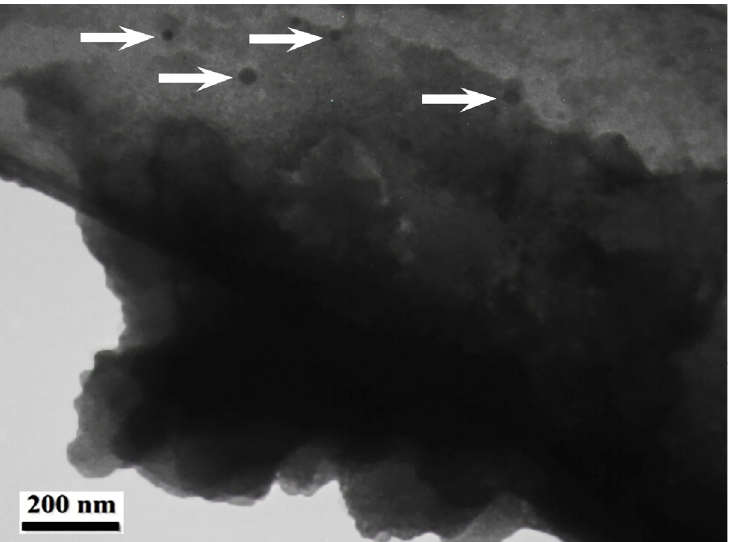
Figure 3. TEM image of SPION@CS − IL catalyst. The arrows show the SPION.